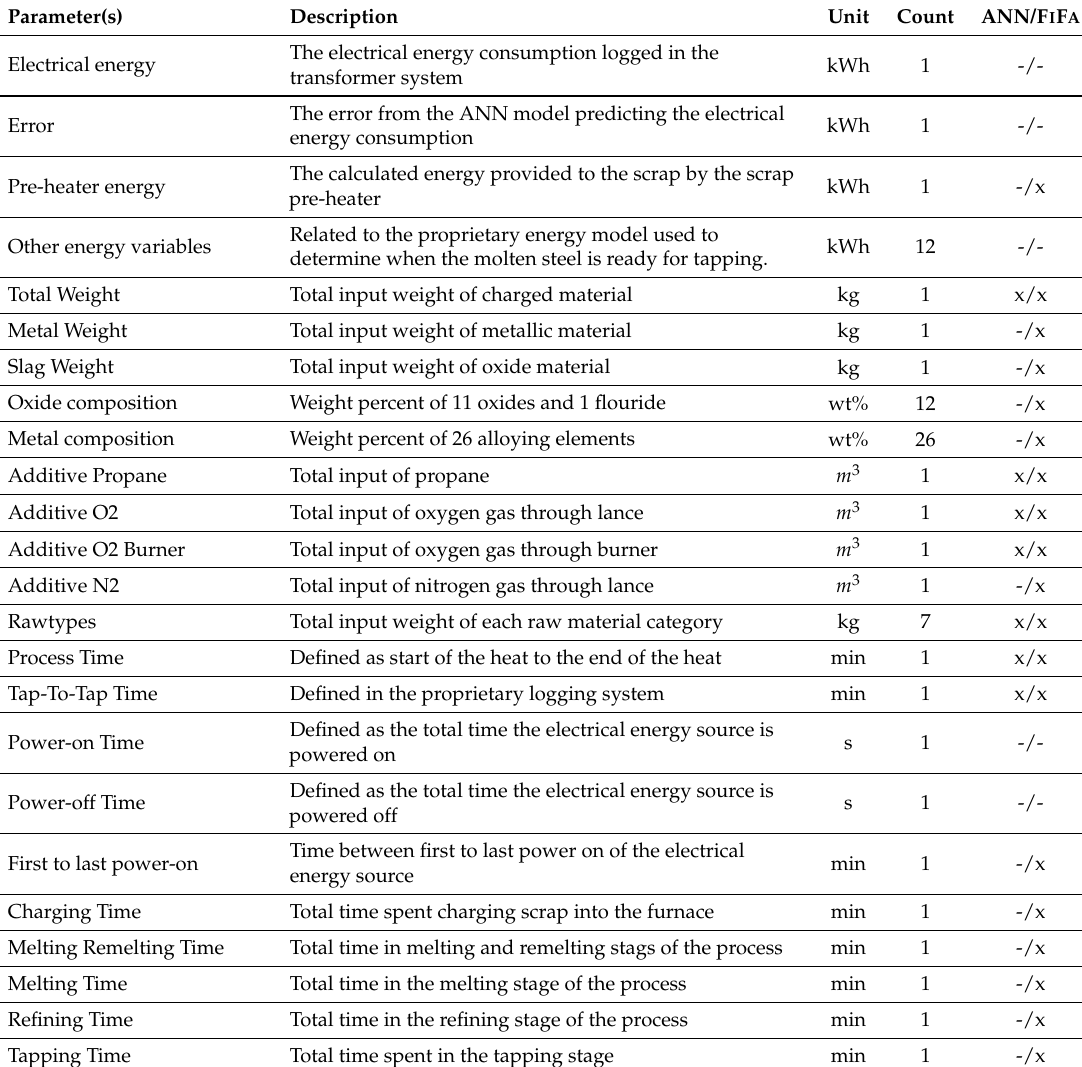
Table A4. All variables used in the EAF case. The “Count” column shows the number of variables representing the parameter. The ANN/F I F A column indicates whether the variables were used as input variables in their respective models: “x” indicates the variable(s) is part of the model while “-” indicates the variable is absent. Completely absent variables in both ANN and F I F A were still part of the qualitative analysis using the KS-statistic to identify groups in the M APPER